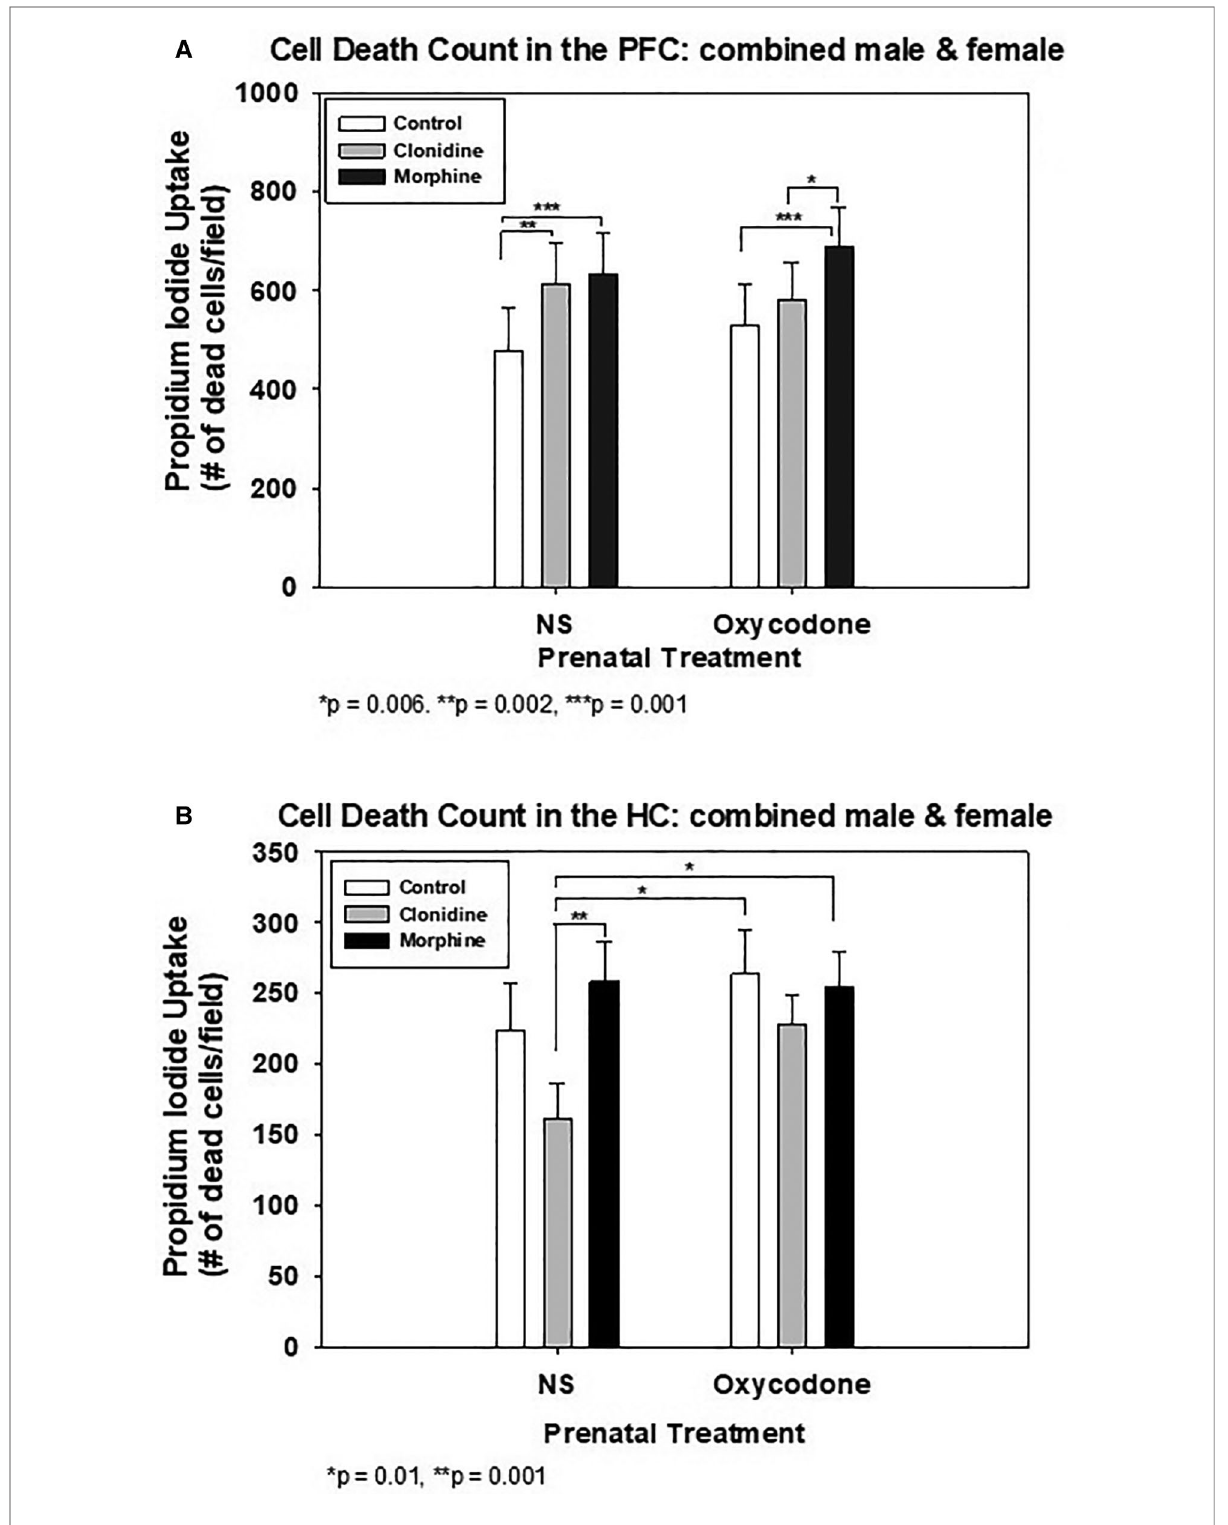
FIGURE 2 Quanti fi cation of cell death in organotypic explants following treatment with clonidine or morphine. ( A ) Prefrontal Cortex (PFC) Explants. ( B ) Hippocampus (HC)